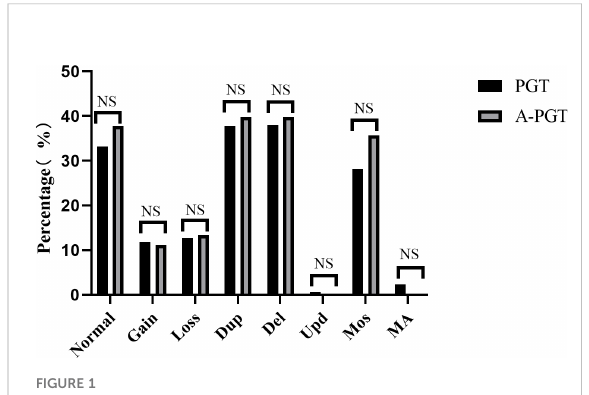
FIGURE 1 Comparative analysis of the chromosomal status of blastocysts in patients between the PGT and A-PGT group. Bars in the graph indicate percentages. Normal karyotype: 46, XX or 46, XY. Gain, increased copy number of the entire chromosome. Loss, at least one entire chromosome is missing. Dup, duplication of a chromosomal fragment. Del, loss of a chromosomal fragment. Upd, uniparental diploidy. Mos, mosaicism. MA, Multiple chromosomal abnormalities containing both duplication or deletion of chromosomal segments and mosaicism. NS indicates no statistically signi fi cant difference between the two